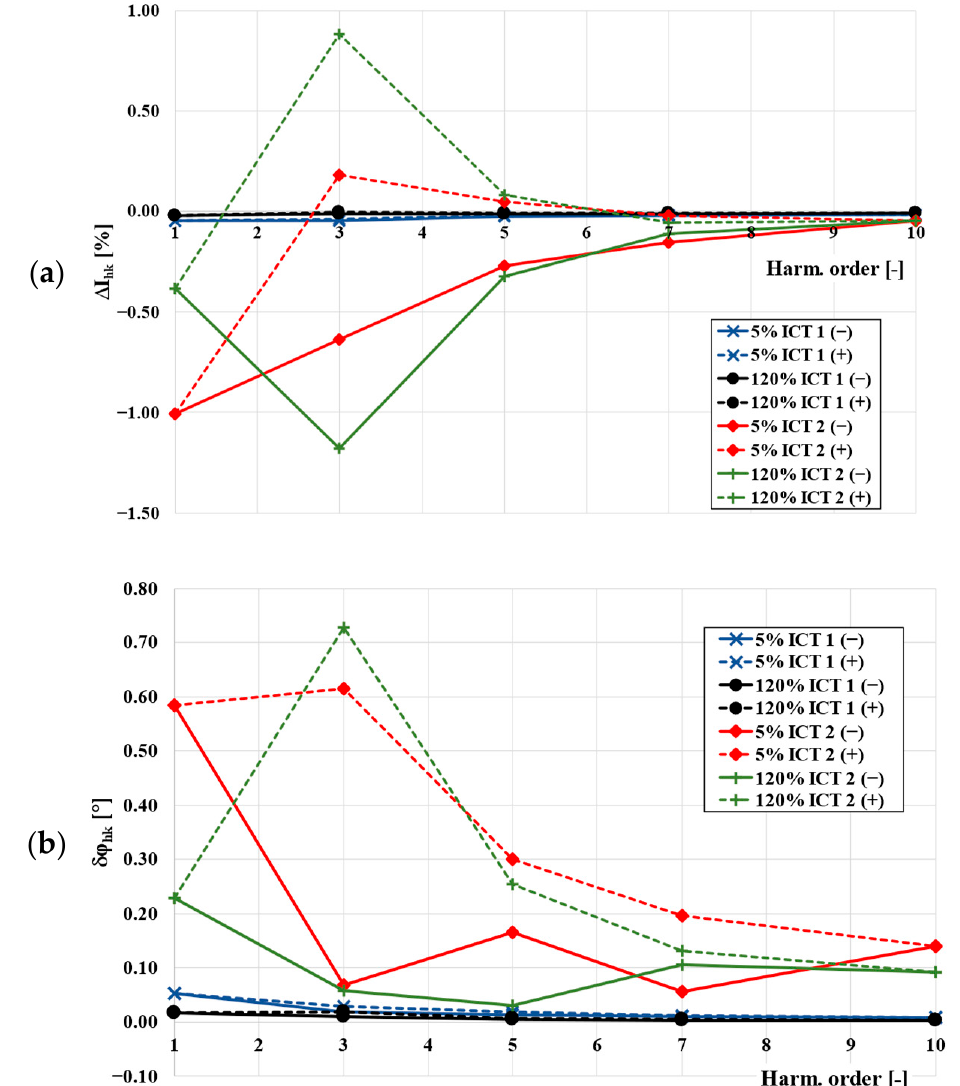
Figure 3. Comparison of determined values of the current error ( a ) and phase displacement ( b ) for both tested CTs up to 10th higher harmonic and rated load of the secondary winding. Considering the self-generation phenomenon for the ICT 2 , the value of the current error of the 3 rd harmonic is between − 1.18% and 0.88% for 120% of the rated primary current. In the case of the 5th harmonic for the same current, the value of current error changes from − 0.32% to 0.08%, depending on the phase angle of the transferred harmonic. Presented results show that ICT 1 is characterized by irrelevant self-generation. In Figure 4, the comparison of determined values of current error and phase displace- ment for both tested CTs up to 100th higher harmonic and rated load of the secondary winding is